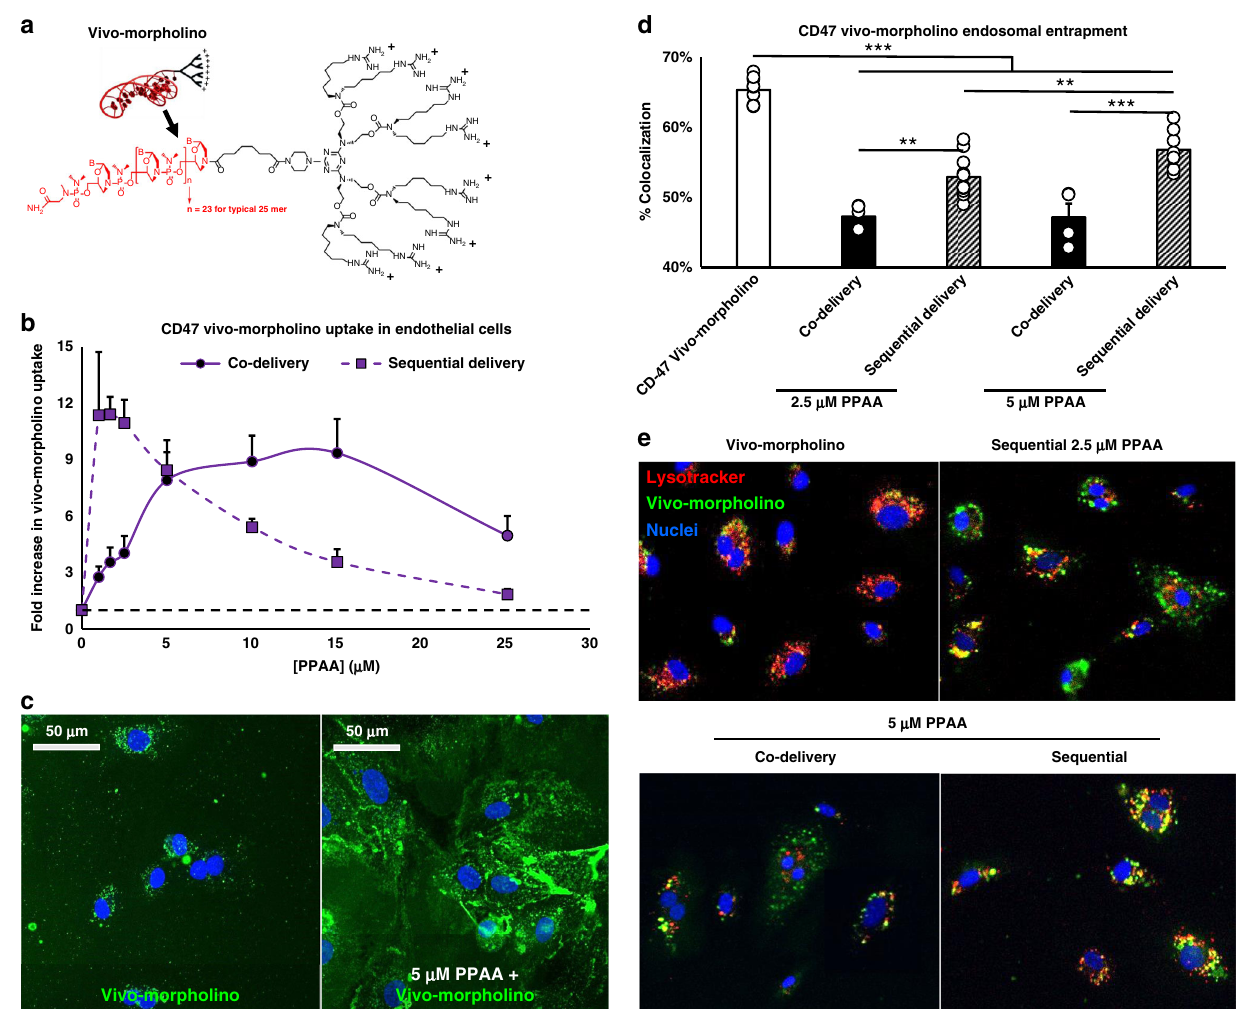
Fig. 5 PPAA broadly enhances delivery of cationic biomacromolecules. a Structure of a vivo-morpholino constituted by phosphorodiamidite morpholino oligomer conjugated to a cationc octa-guanidine dendrimer. b Quanti fi cation and c representative confocal microscopy images of polymer dose-dependent CD47 vivo-morpholino uptake in human microvascular endothelial cells. d Quanti fi cation and e representative confocal microscopy images of vivo- morpholino (green) colocalization with the endolysosomal dye lysotracker (red). * p < 0.05, ** p < 0.01, *** p < 0.001; one-way ANOVA followed by Tukey ’ s post hoc test. Data are presented as means ±